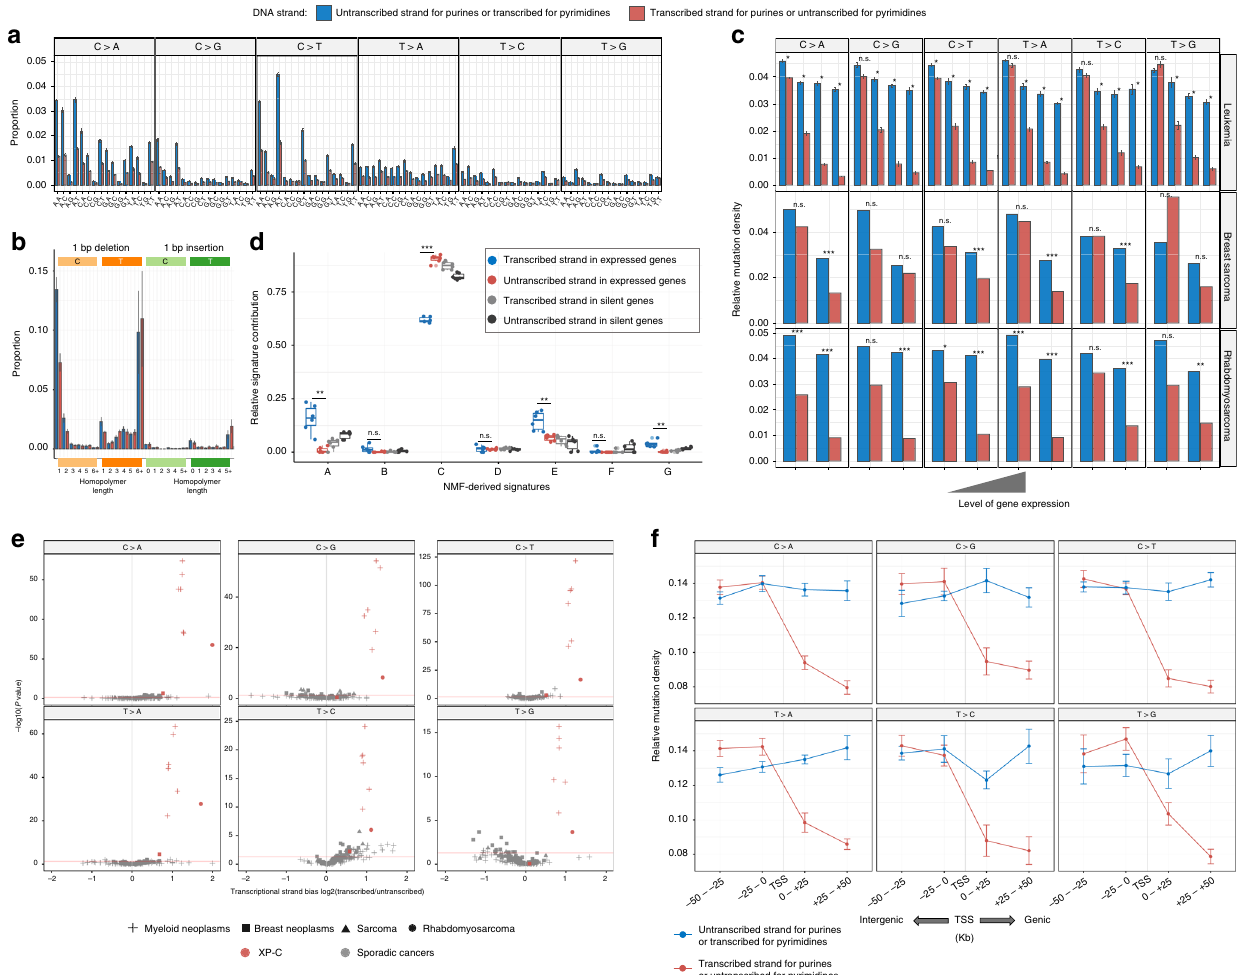
Fig. 3 Strong transcriptional bias (TRB) is a speci fi c feature of XP-C tumors. a TRB is observed in the majority of trinucleotide contexts of XP-C leukemia samples ( n = 6, SEMs are indicated). b TRB is highly pronounced for speci fi c single nucleotide C:G deletions in XP-C leukemia samples ( n = 6, SEMs are indicated). c TRB strength depends on the level of gene expression and is most pronounced in highly expressed genes (SEMs are indicated for leukemia; Poisson, two-sided test used for breast sarcoma ( n = 1) and rhabdomyosarcoma ( n = 1); Wilcoxon signed-rank, two-sided test for leukemia ( n = 6), P : ns — nonsigni fi cant, *<0.5, **<0.01, ***<0.001). d Relative mutational signature contribution for mutations separated by transcribed and untranscribed strands in transcriptionally active (FPKM > 2) and silent genes (FPKM < 0.05) of XP-C leukemia. Boxes depict the interquartile range (25 – 75% percentile), lines — the median, whiskers — 1.5× the IQR below the fi rst quartile and above the third quartile. Predominant in XP-C leukemia Signature “ C ” is depleted on the transcribed strands with functional TC-NER, but relative contribution of signatures “ A ” and “ E ” typical for sporadic leukemia is enriched on the transcribed strand ( t test, two-sided, paired between transcribed and untranscribed strands in expressed genes ( n = 6), P : ns — nonsigni fi cant, *<0.5, **<0.01, ***<0.001). e TRB is highly signi fi cant and pronounced in XP-C samples for all six substitution classes in comparison with sporadic cancers (Poisson two- sided test). f The strong TRB observed in XP-C leukemia ( n = 6) is caused by transcriptional-coupled repair (TC-NER) but not transcriptional-associated damage. Strong decrease of mutation rate is observed on the genic untranscibed strand for pyrimidines (transcribed for purines, red; right side of transcription start site, TSS), but not on the transcribed strand for pyrimidines (untranscribed for purines, blue) as compared to neighboring intergenic regions (±50 kbp from transcription start site, SEMs are